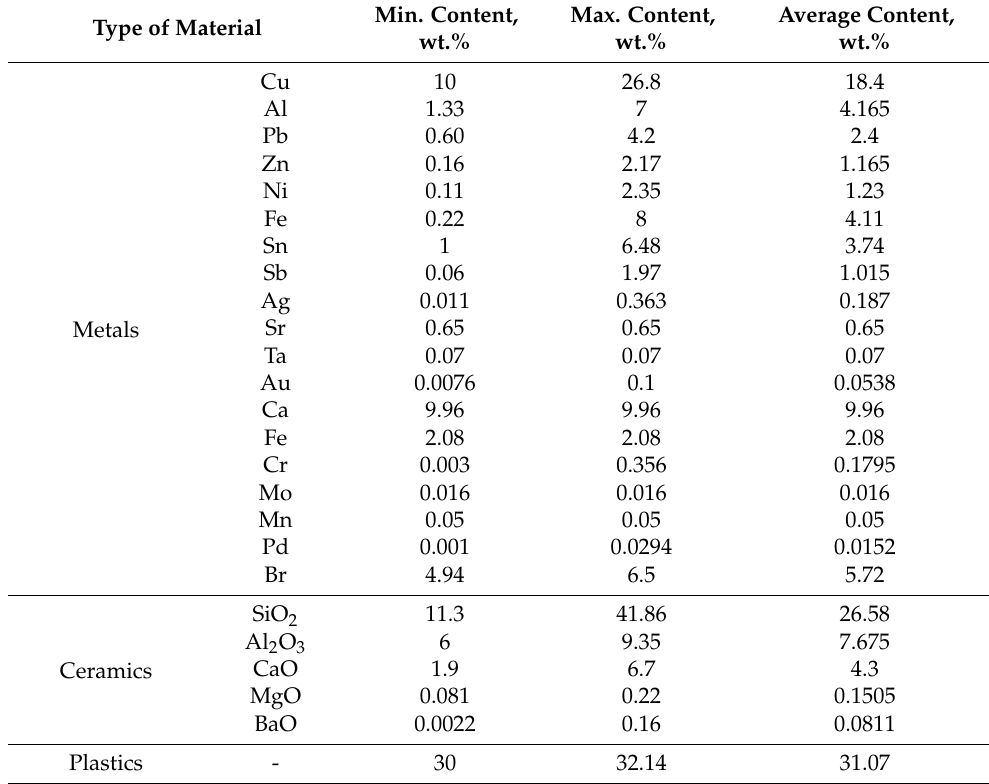
Table 1. PCB material composition